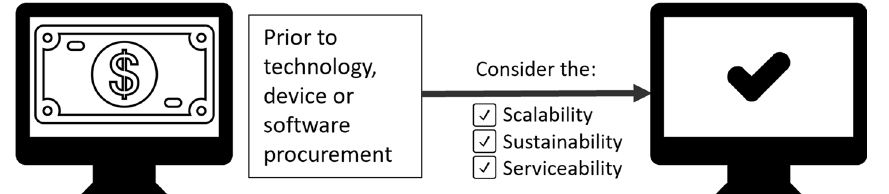
Fig. 2 Checklist of considerations: scalability, sustainability, and